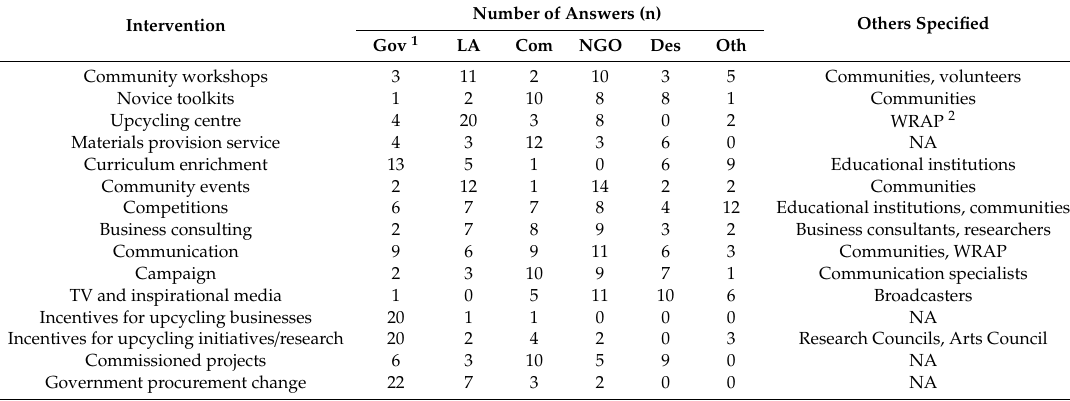
Number of Answers (n)